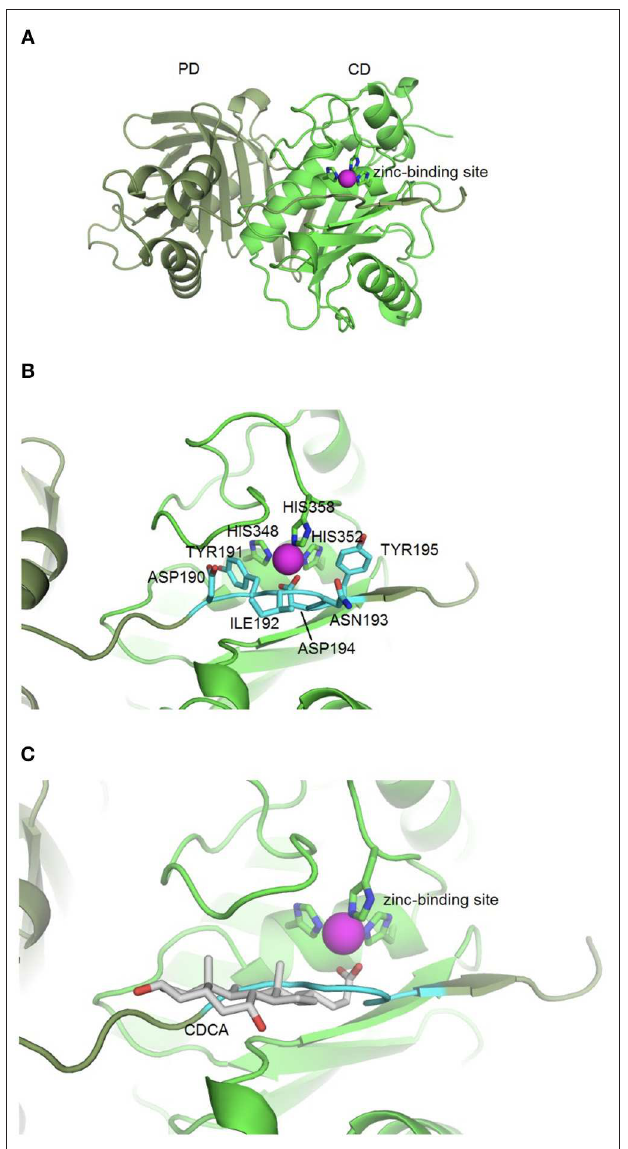
FIGURE 1 | BFT-3 structure. (A) BFT structure and active site BFT-3 structure including pro-domain (PD, dark green) and catalytic domain (CD, light green) and zinc-binding site (zinc in purple). (B) Pro-domain residues (ASP190, TYR191, ILE192, ANS193, ASP194, and TYR195) used for defining the BFT-3 binding pocket (light blue) and zinc coordinating residues from the CD (HIS348, HIS352, and HIS358). (C) Chenodeoxycholic acid docked into the BFT-3 zinc-binding site using MOE.